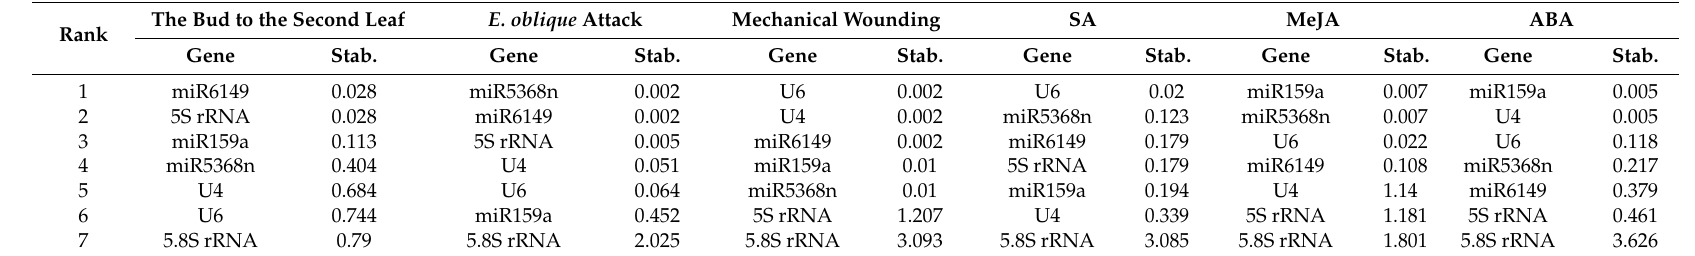
Table 3. Expression stability ranking of candidate reference genes as calculated by